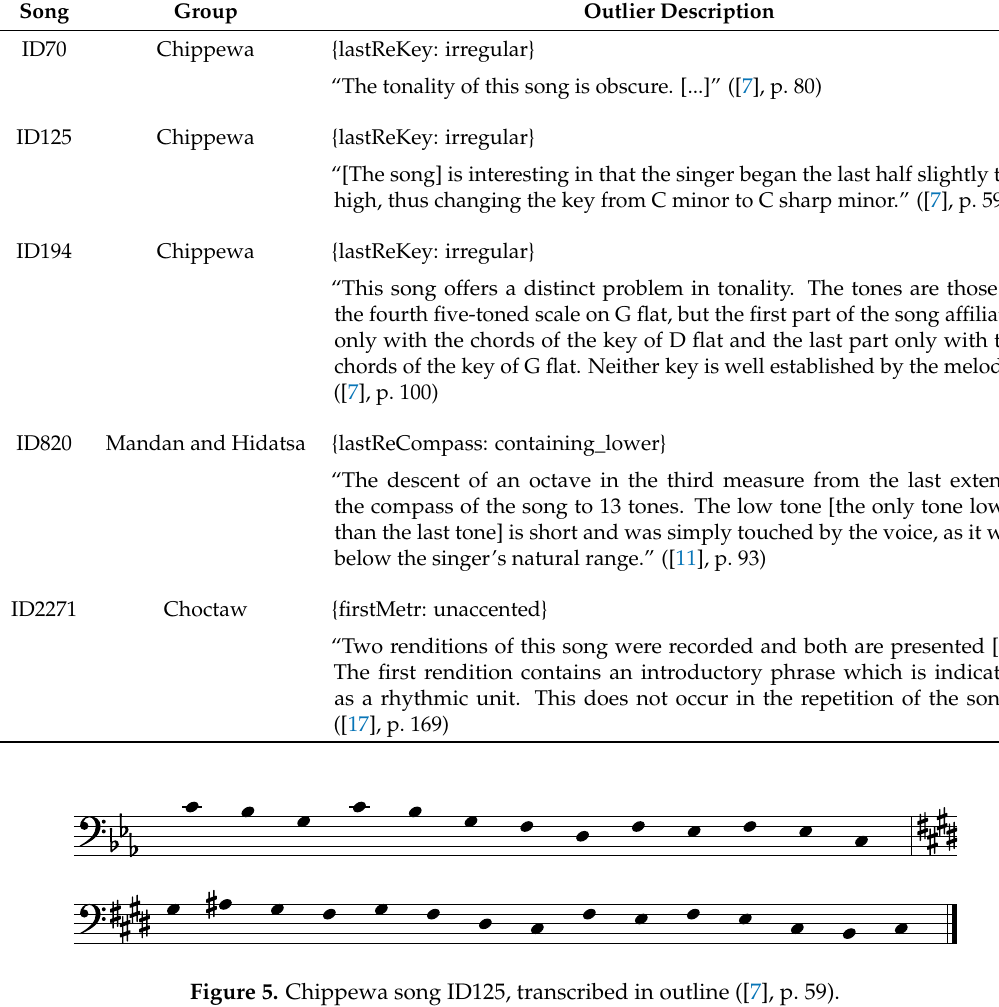
Table 6. Outliers in the Densmore collection with reference to performance or encoding.